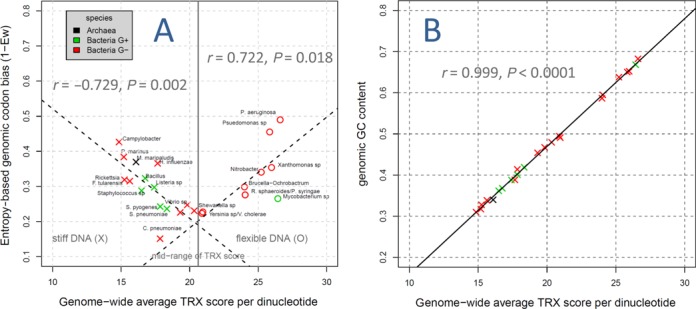
A fundamental relationship between intrinsic DNA flexibility (TRX score), genomic GC content and entropy-based codon bias. (A) Prokaryotic genomes with uncharacteristically stiff or flexible genome architecture, and thus deviating from the middle of the TRX scale, demonstrate increased codon bias. (B) The relationship between GC content and intrinsic DNA flexibility at the genomic level is particularly pronounced, reflecting the trends easily observed in the TRX scale, where flexibility increases with GC containing dinucleotides.